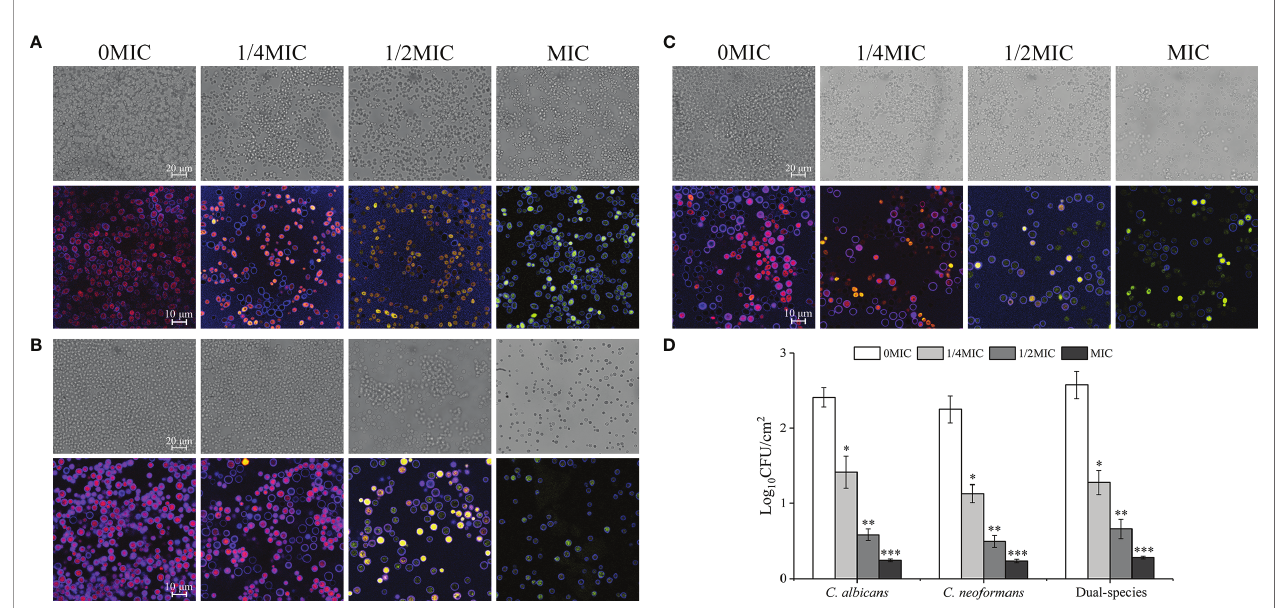
FIGURE 4 | Effect of paeonol on the adhesion to an abiotic surface and metabolic activity of C. albicans SC5314, C. neoformans H99, and dual-species. (A – D) The changes of C. albicans SC5314 (A) , C. neoformans H99 (B) , and dual-species (C) adhesion were assessed using a confocal laser scanning microscope (CLSM) in bright- fi eld mode and viable cell counts (D) when exposed to fi nal concentrations of paeonol at 0, 1/4 MIC, 1/2 MIC, and MIC. (A – C) The metabolic activity of treated and untreated C. albicans SC5314 (A) , C. neoformans H99 (B) , and dual-species (C) were evaluated using CLSM in combination with FUN ® 1/Calco fl uor ® White M2R dyes under fl uorescence and re fl ection mode. Scale bars represent 20 m m for bright- fi eld mode and 10 m m for fl uorescence and re fl ection mode. Bars represent the standard deviation ( n = 3). * p < 0.05; ** p < 0.01; *** p <